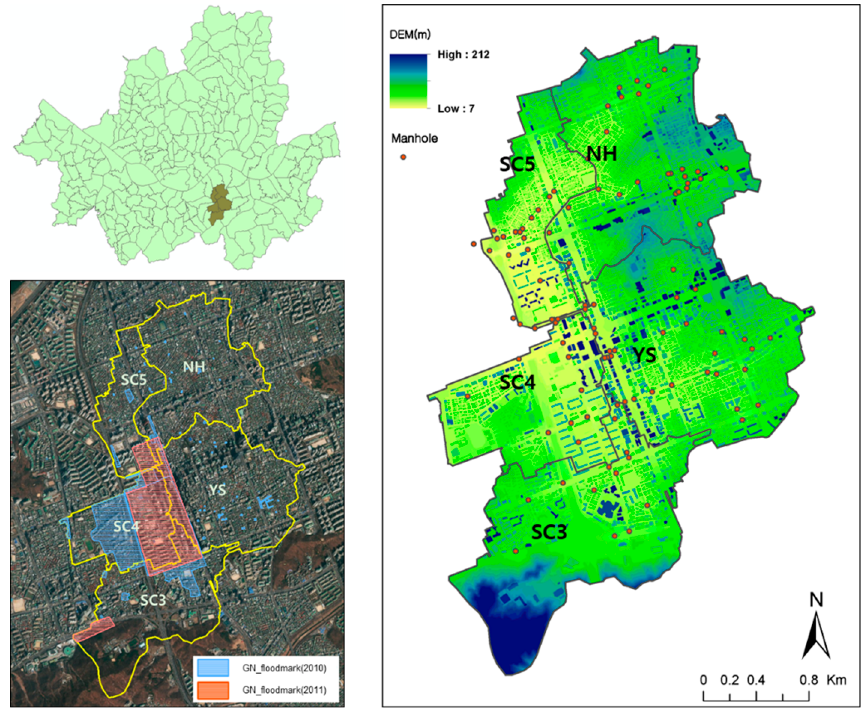
Figure 1. Study area and inundation trace.